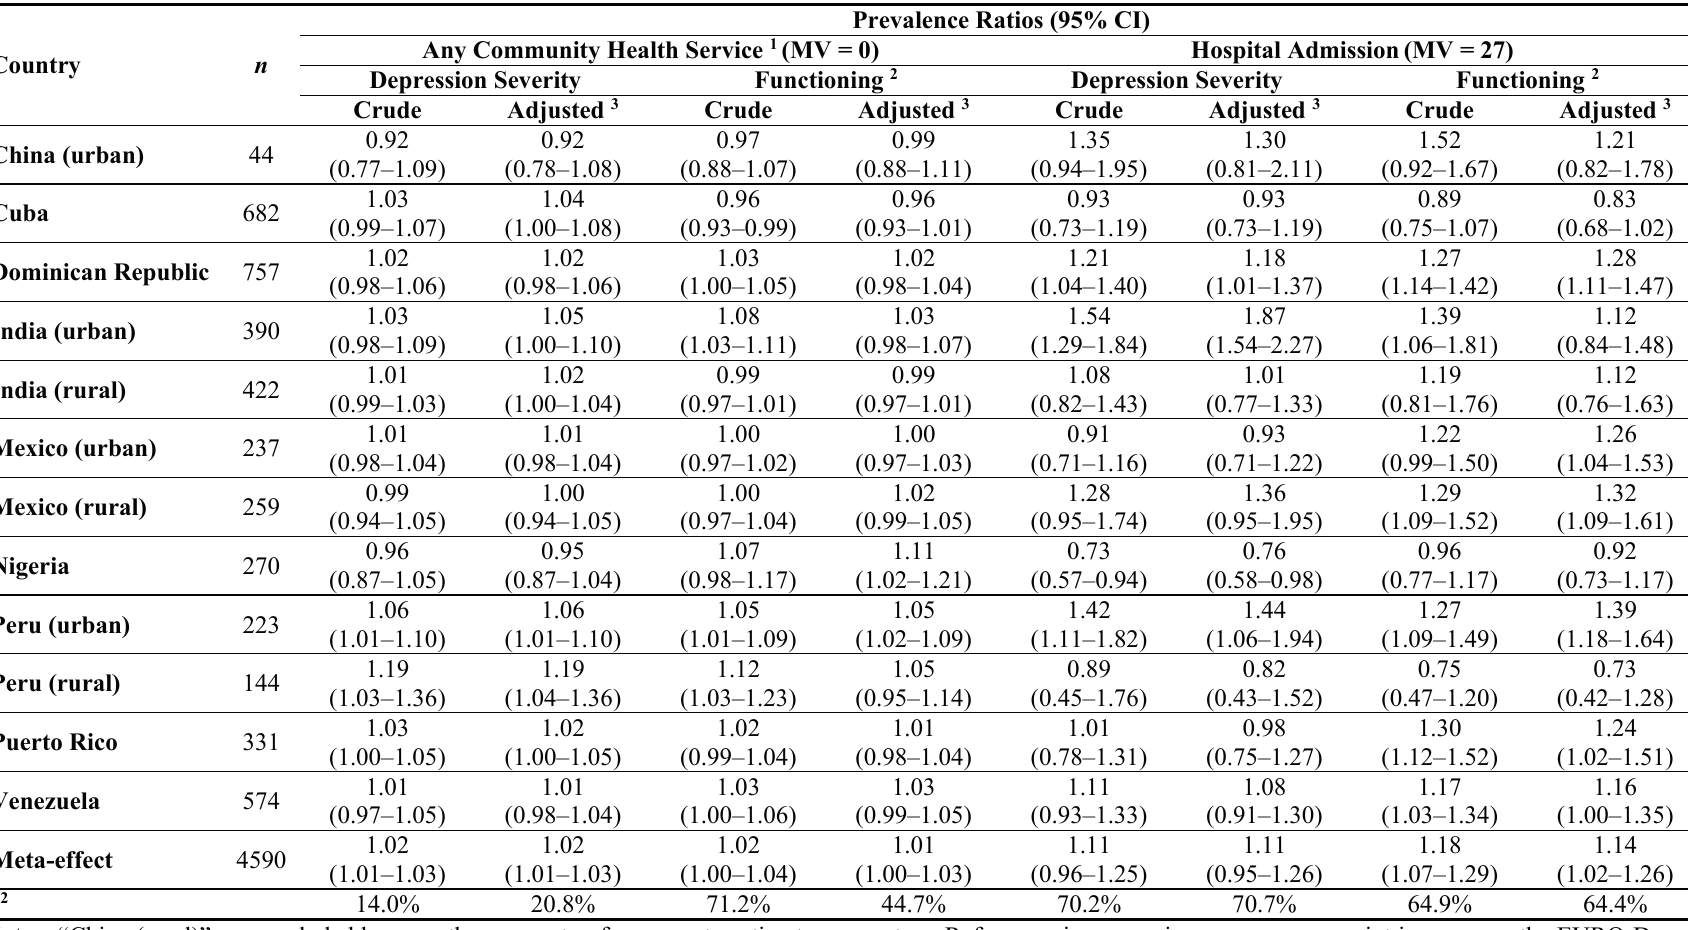
Table 3. Associations of depressive symptom severity (EURO-D total score) and functioning (WHODAS-II total score) with health service